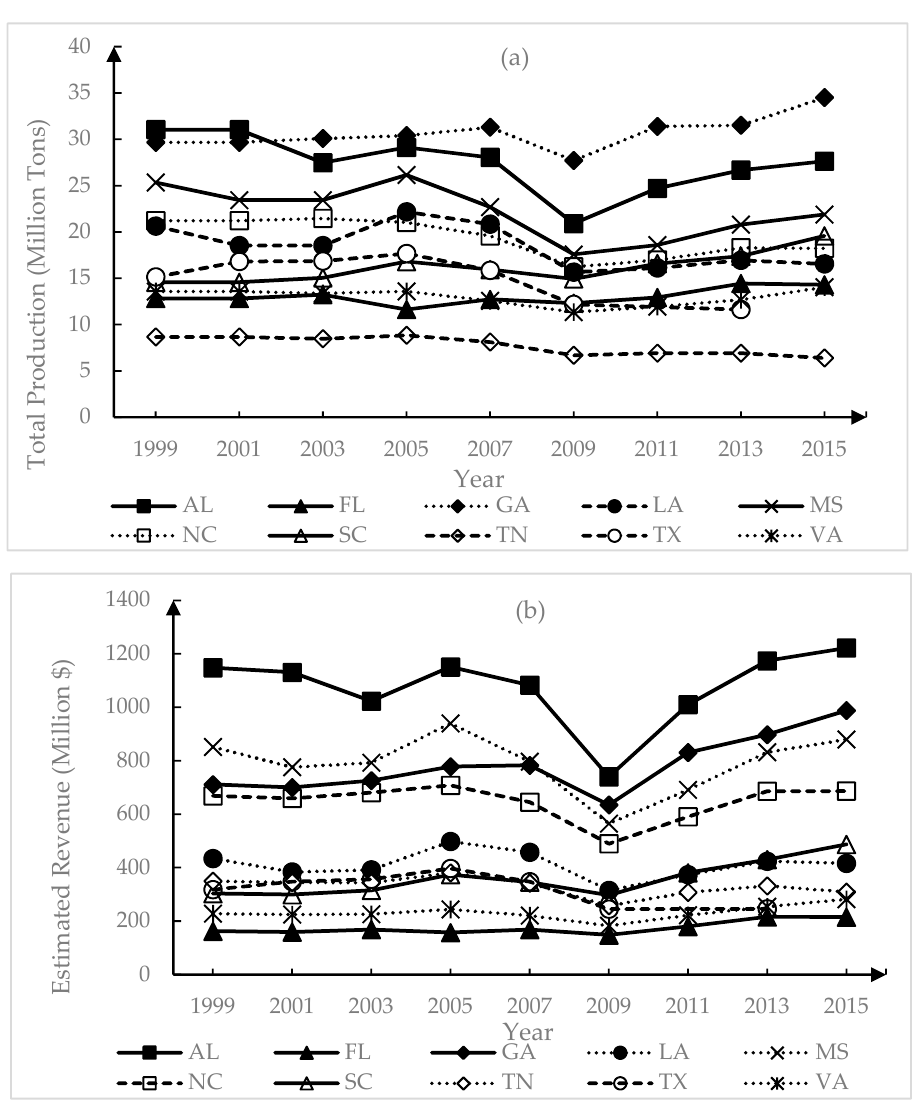
Figure 5. Logging industry ( a ) production level and ( b ) estimated revenue in some states, 1999 to 2015 [37,43,75]. Notes: AL, FL, GA, LA, MS, NC, SC, TN, TX, and VA signify Alabama, Florida, Georgia, Louisiana, Mississippi, North Carolina, South Carolina, Tennessee, Texas, and Virginia, respectively.